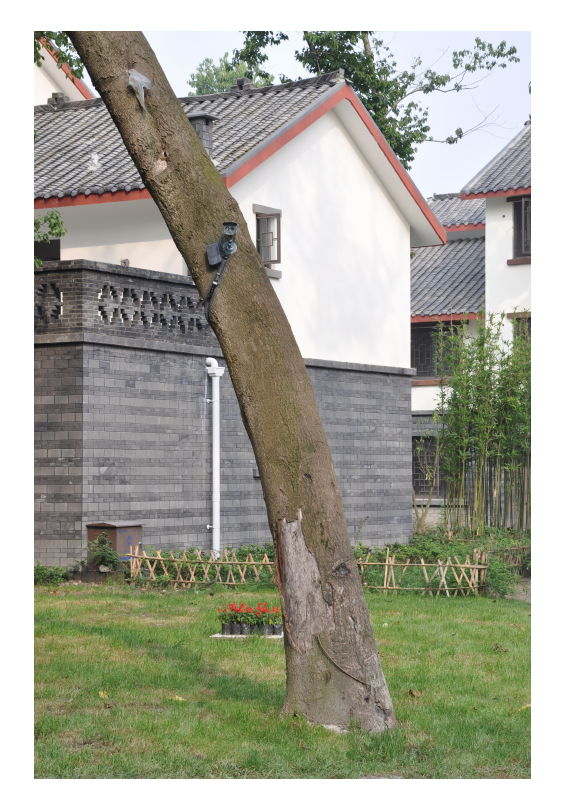
FIGURE1 Surveillance camera installed on tree in newly redeveloped village in rural Chengdu. Photograph by author, July